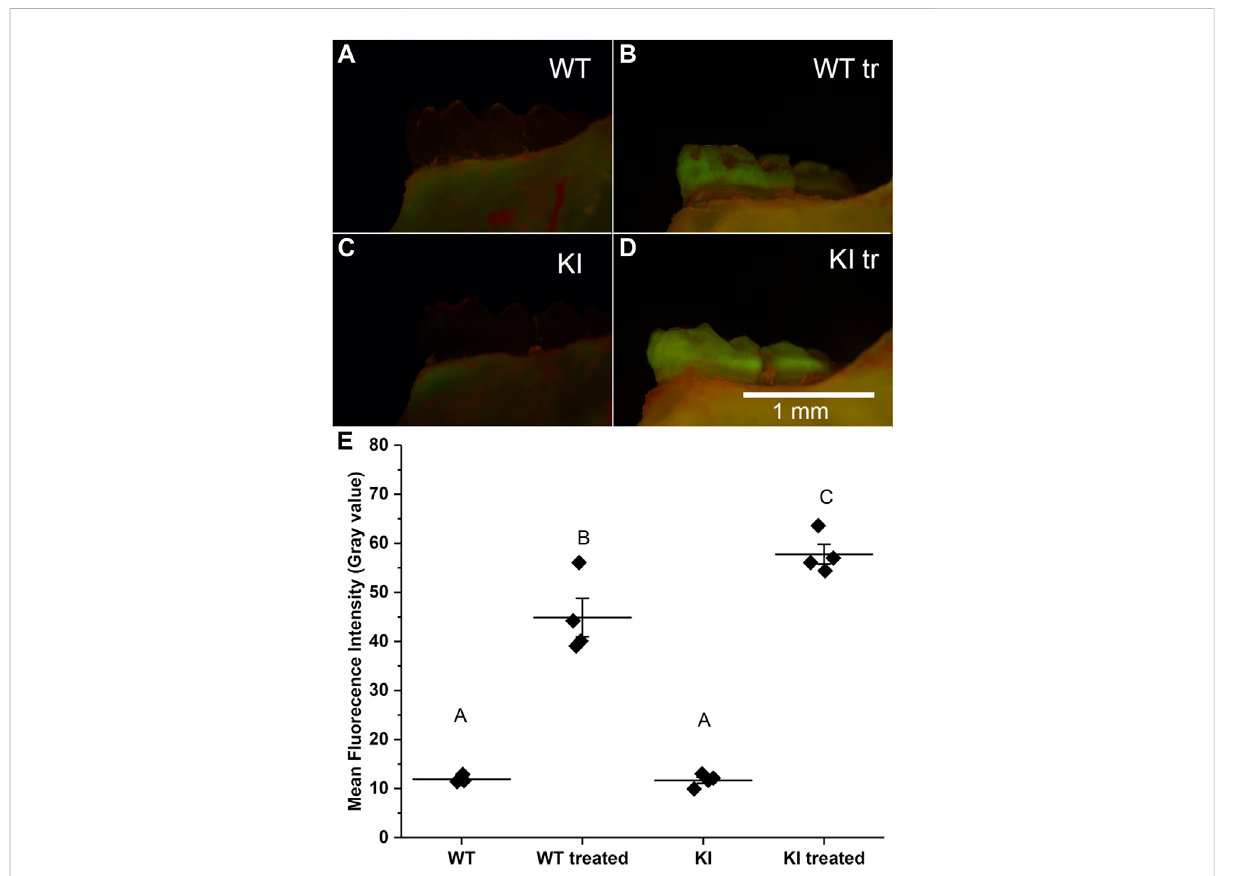
FIGURE 2 Micrographs of hemimandibles in buccal view of (A) untreated WT, (B) treated WT, (C) untreated KI, (D) treated KI. (E) A plot of mean fl uorescence intensity (grey values) obtained for buccal surfaces of 1st molars. Diamonds represent mean fl uorescence intensity for each specimen. Horizontal lines represent mean values for each group and whiskers indicate standard errors. Similar letters indicate populations which are not signi fi cantly different from each